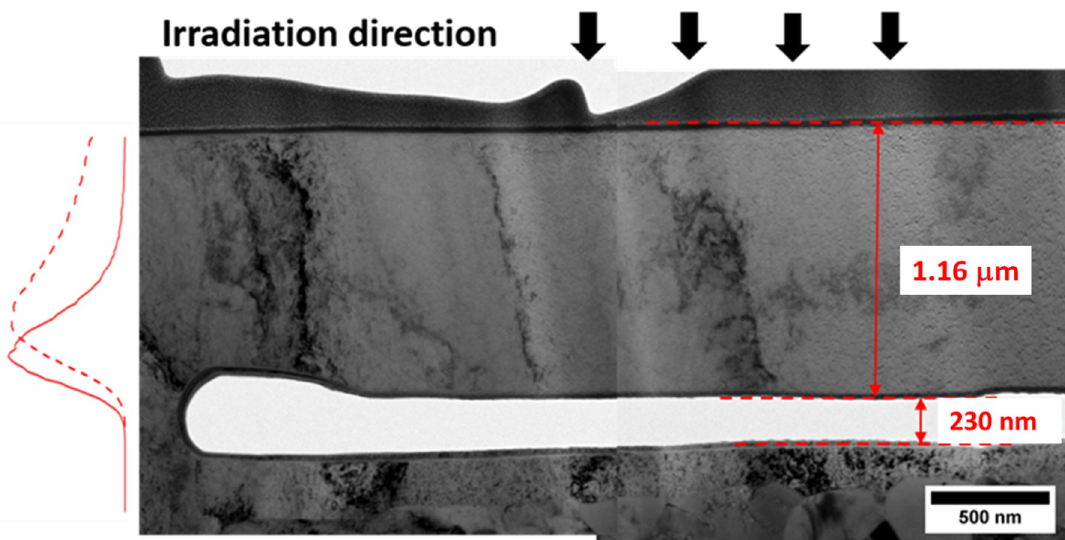
Figure 8. TEM micrograph of irradiated Fe containing a trench with an upper surface located at the depth 1.16 µ m, corresponding to just under the peak of the injected interstitial distribution.